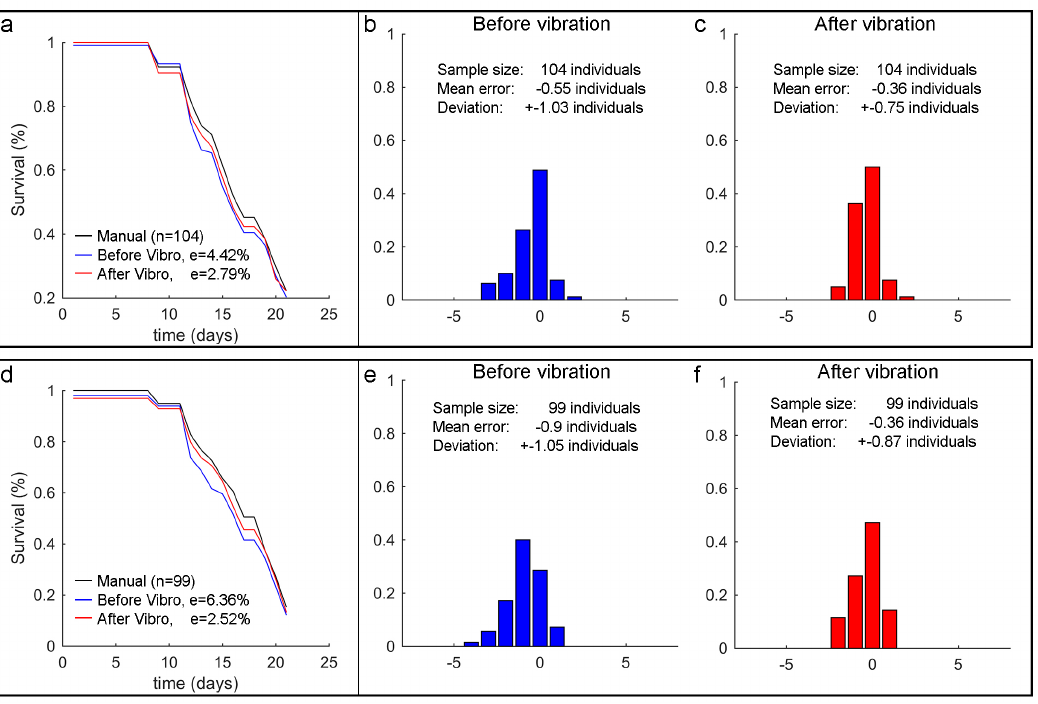
sample (subjected to a 1 s 9 − t 1 9 − t 5